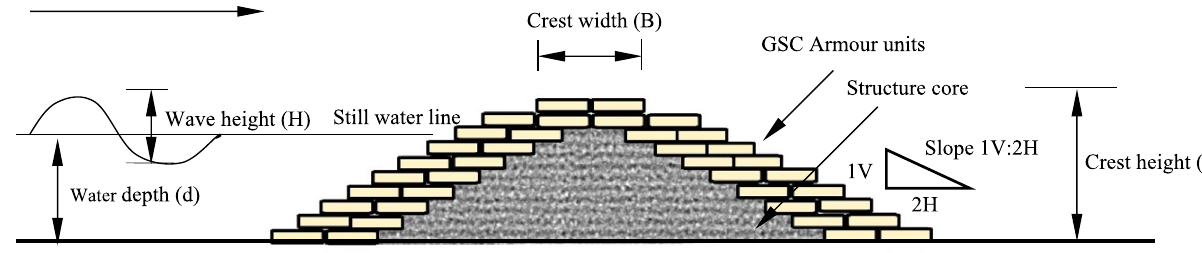
Figure 3. Representation of the constructed GSC breakwater model 26